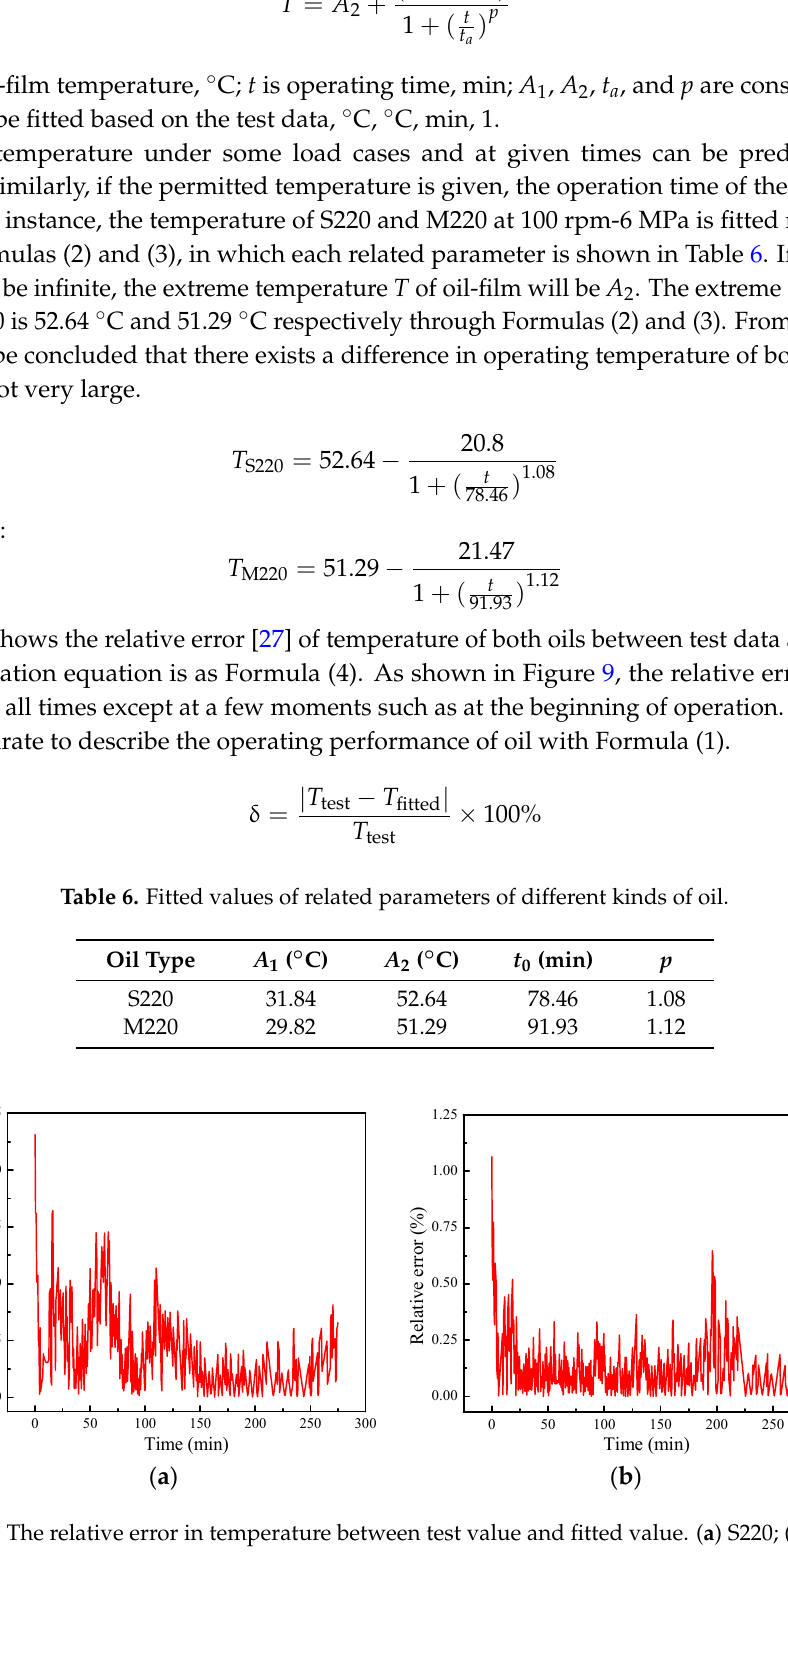
Figure 9. The relative error in temperature between test value and fitted value. ( a ) S220; ( b ) M220.